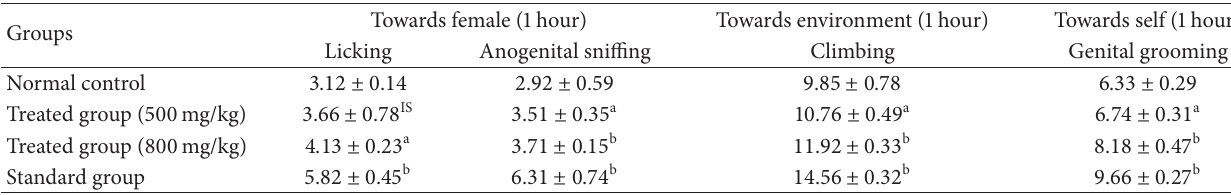
Table 3: Effect of Cydonia oblonga extract on orientation activities of male rats towards females, towards environment, and towards self on the 14th day of the study.